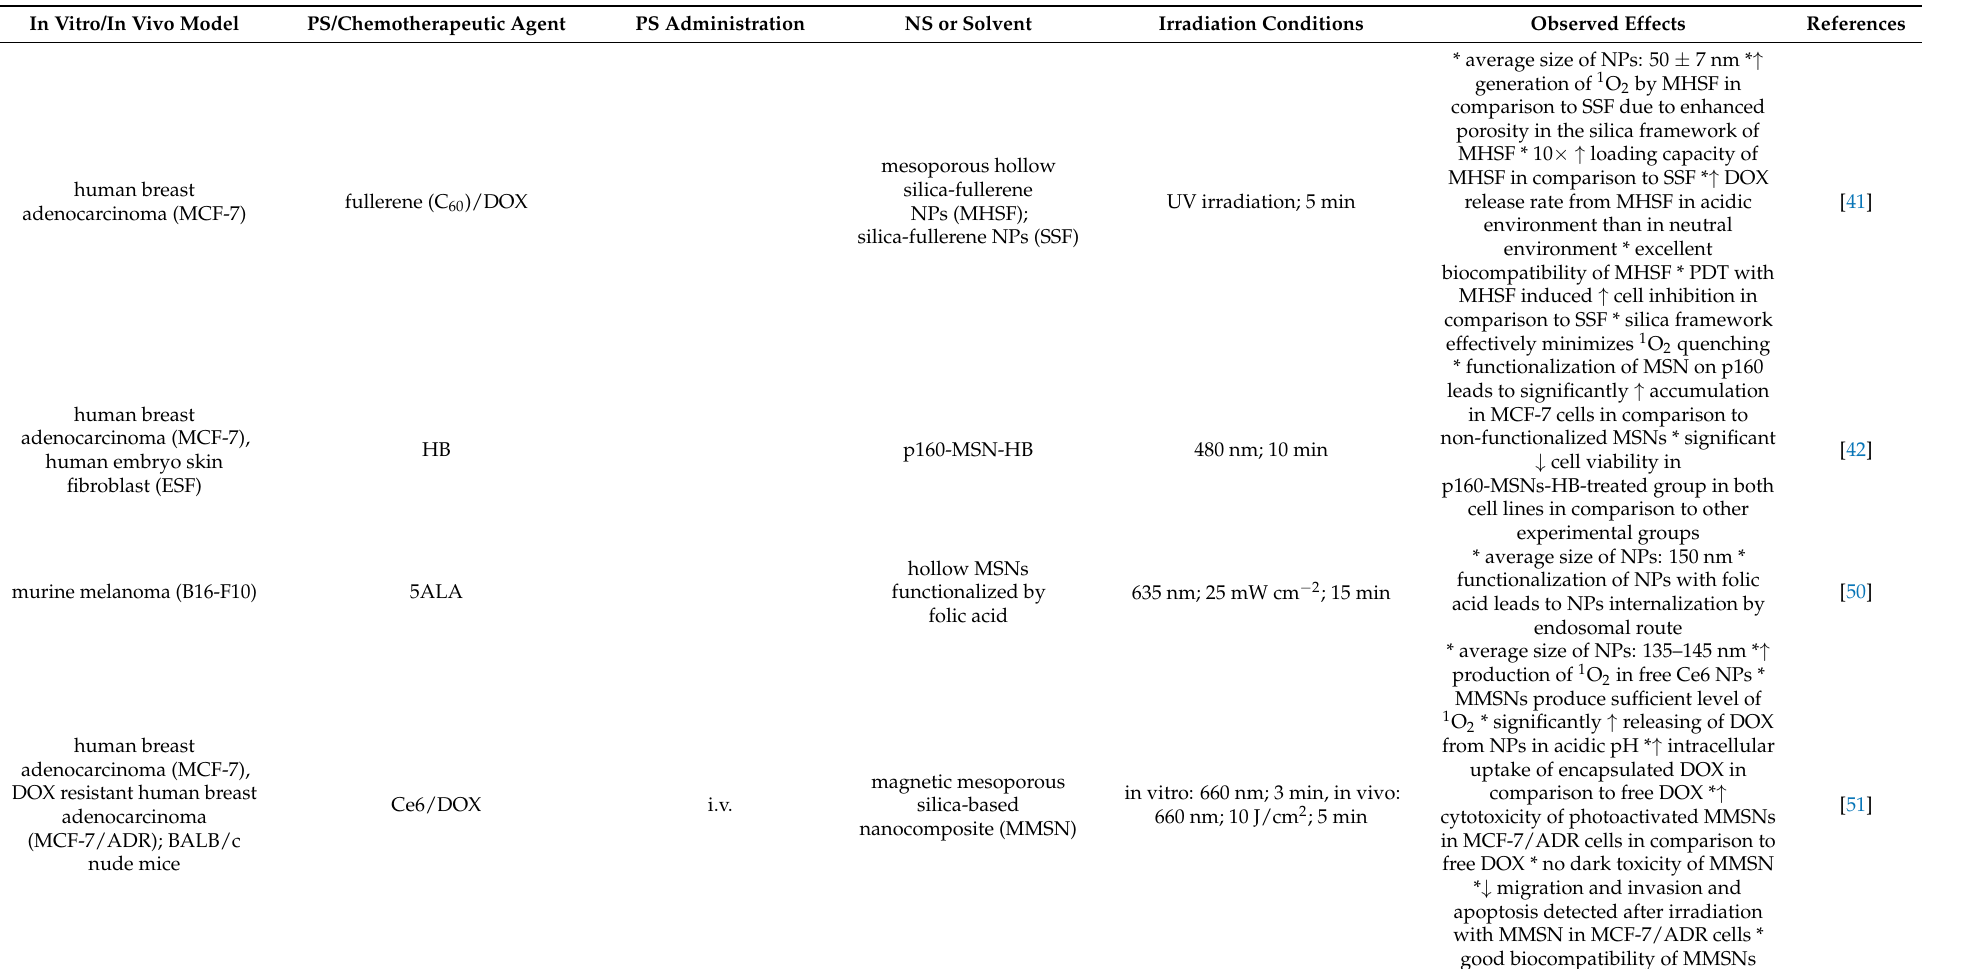
Table 2. Application of combined chemo-PDT with NPs and functionalized NPs for the purposes of MDR effect